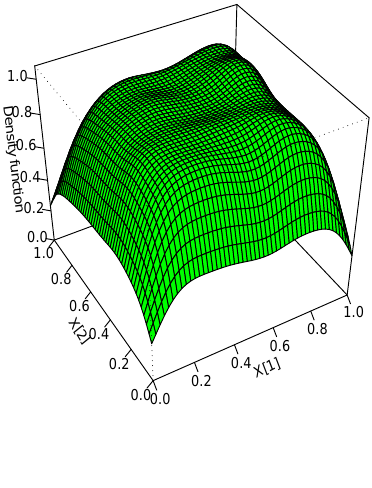
Figure 2. Graph of the independent copula